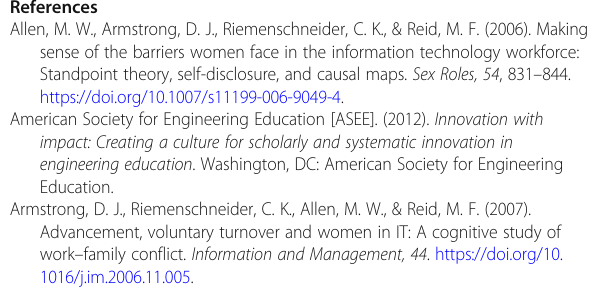
Table 10 Inter-rater reliability for the Modification Identification Framework (MIF): Gwet ’ s AC1 values (per code) Code Gwet ’ s Instructional